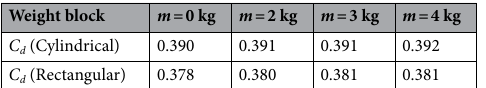
Table 2. H = 0.15 m, stable value of resistance